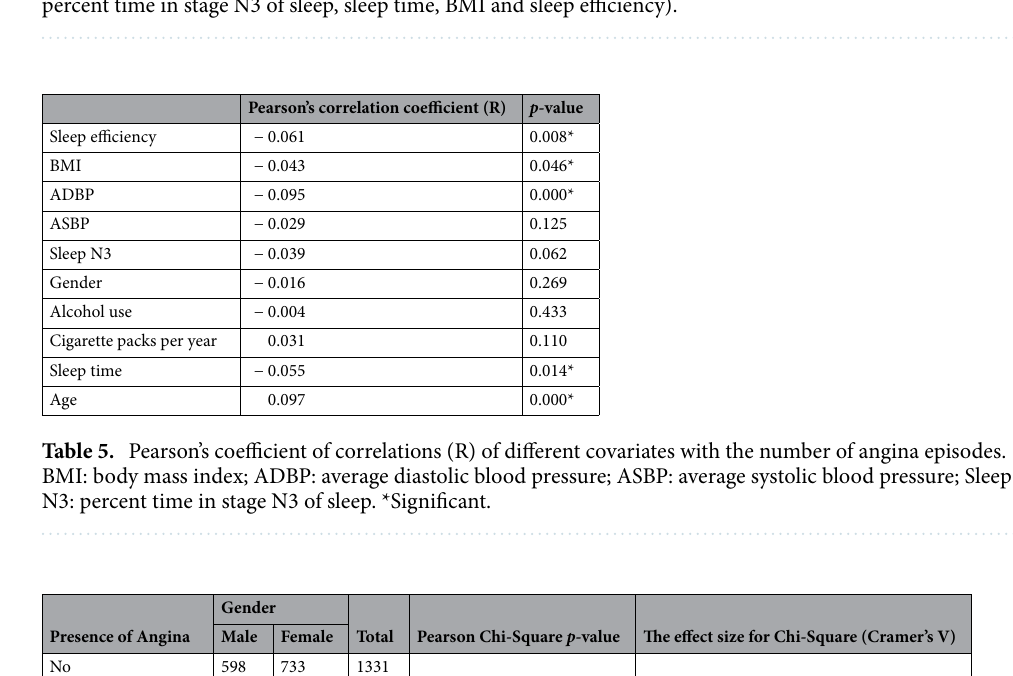
Table 4. Model summary for adjusted predictors (dependent variable: number of angina episodes; predictors (constant): age, alcohol use, average diastolic blood pressure, average systolic blood pressure, cigarette use, percent time in stage N3 of sleep, sleep time, BMI and sleep efficiency).